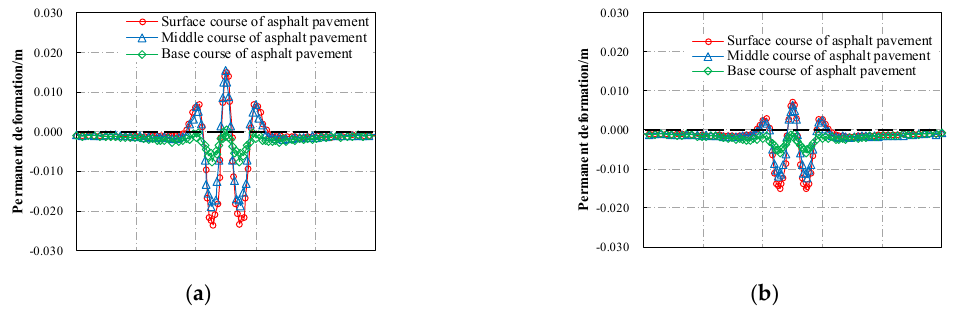
Figure 13. Distributions of permanent deformation at different depths: ( a ) Conventional asphalt pavement; ( b ) Cooling asphalt pavement with CASMA thermal insulation layer.